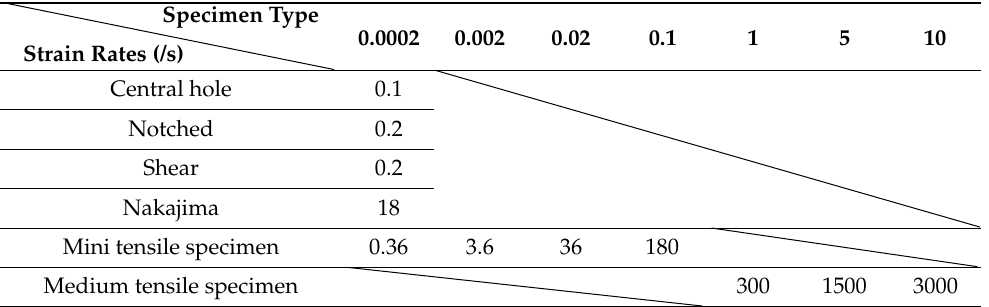
Figure 3. Shape and size of specimens: ( a ) notched; ( b ) shear; ( c ) central hole; ( d ) Nakajima specimen; ( e ) mini tensile specimen; ( f ) medium tensile specimen. Table 3. The crosshead’s velocity for various tensile specimens (mm/min).